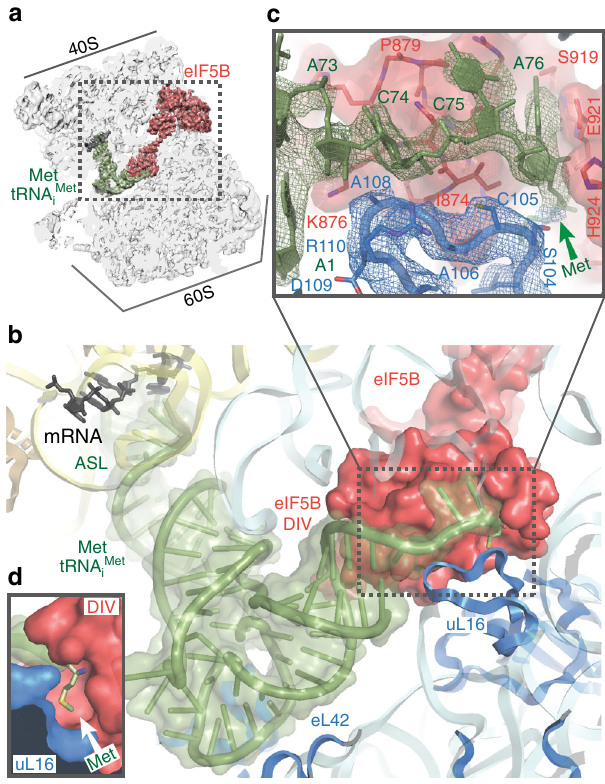
Fig. 3 Ribosomal protein uL16 collaborates with eIF5B DIV in Met- tRNA i Met A76-Met recognition. a Overall view of the 80S/Met-tRNA i Met / eIF5B complex in an orientation centered on eIF5B DIV. b A detailed view of the Met-tRNA i Met conformation adopted while simultaneously interacts with the mRNA and eIF5B DIV on the 80S. c A detailed view of eIF5B DIV focused on the acceptor stem region of Met-tRNA i Met . DIV of eIF5B is shown in red as semi-transparent Van der Waals surface, Met-tRNA i Met nucleotides depicted in green with experimental cryo-EM density shown and uL16 residues are in blue with experimental cryo-EM density shown. d DIV of eIF5B and residues 102 – 110 of uL16 form a hydrophobic cavity where the methionine residue of Met-tRNA i Met is